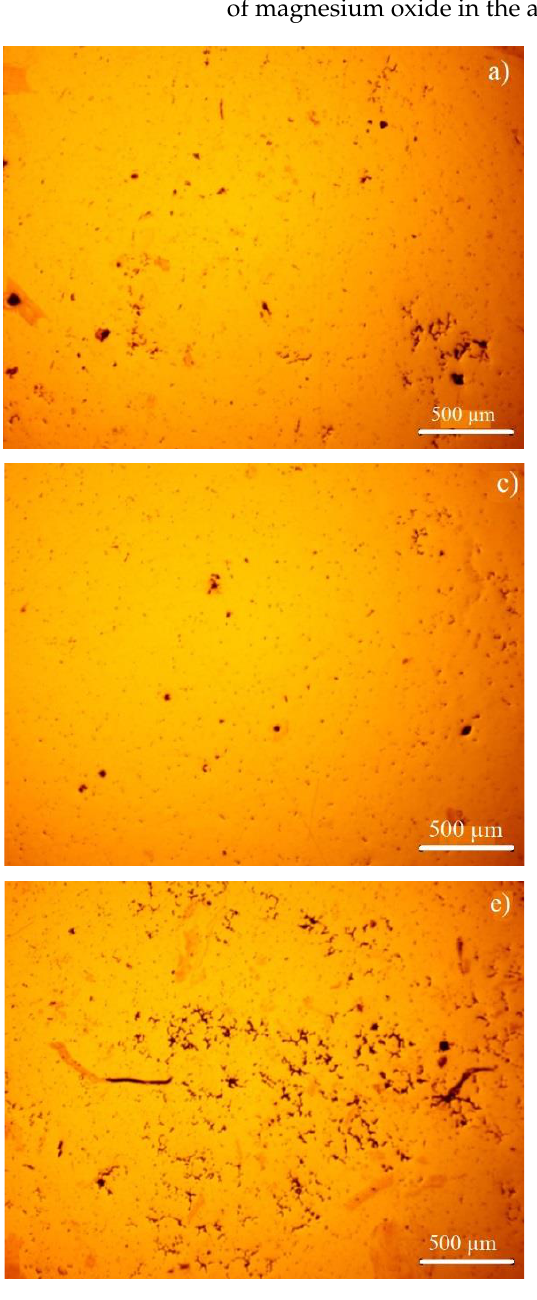
Figure 2. Optical images of magnesium alloys Mg – Ca – Zn reference ( a , b ), Mg – Ca – Zn – ND ( c , d ) and Mg – Ca – Zn US ( e , f ) under natural ( a , c , e ) and polarized ( b , d , f )